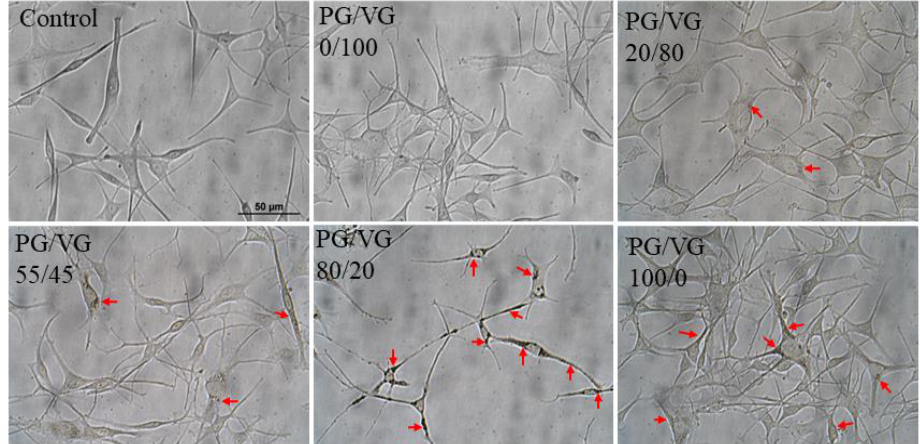
Figure 4. Bright-field images of human melanocytes at 40× magnification after 48 h exposure to a 2% v/v e-liquid solution containing PG/VG at a ratio of 0/100, 20/80, 55/45, 80/20, and 100/0. Red arrows denote the melanin granules within cells.